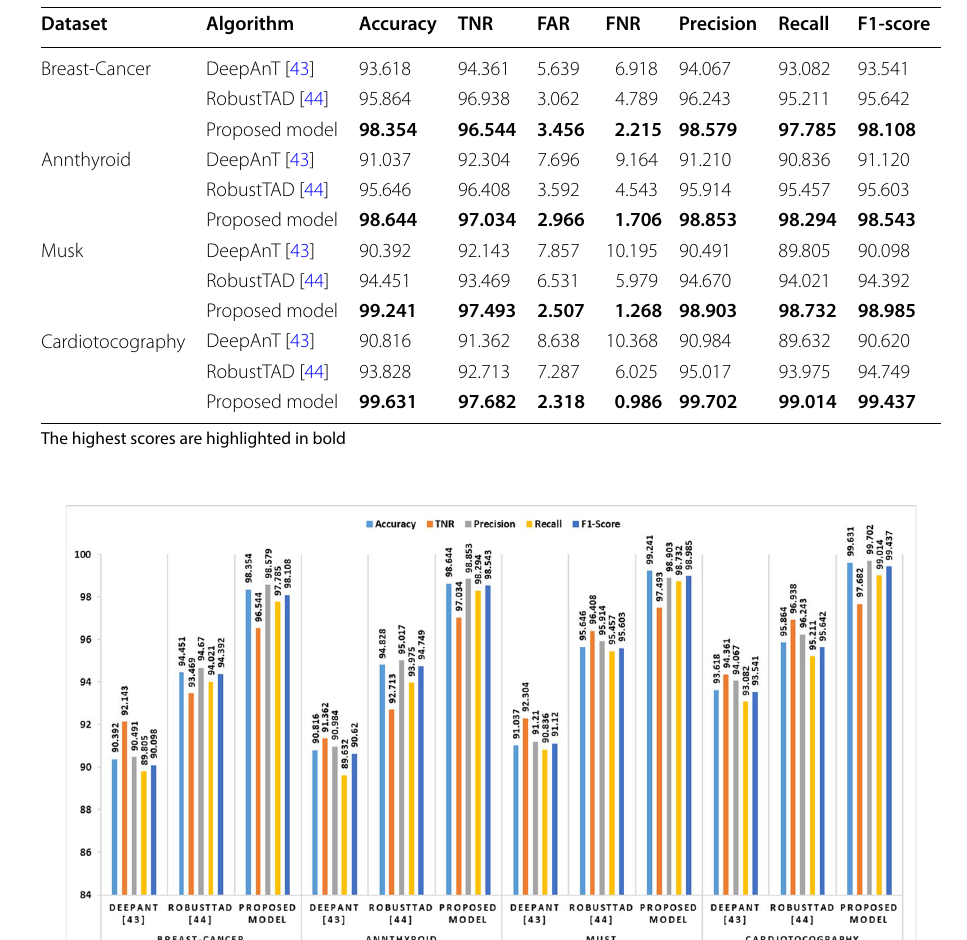
Table 4 Performance evaluation of different DL methods (%) Dataset